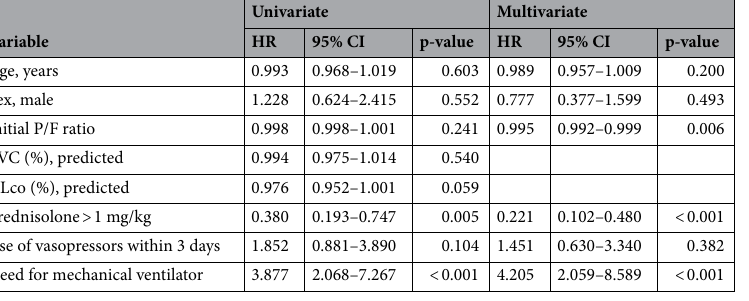
Table 5. Cox regression analysis of risk factors related to 90-day mortality in AE-ILD. AE-ILD acute exacerbation of interstitial lung disease, FVC forced vital capacity, DLco diffusing capacity of carbon monoxide, P/F ratio partial pressure of oxygen in arterial blood (PaO 2 )/fraction of inspired oxygen (FiO 2 ) ratio, HR hazard